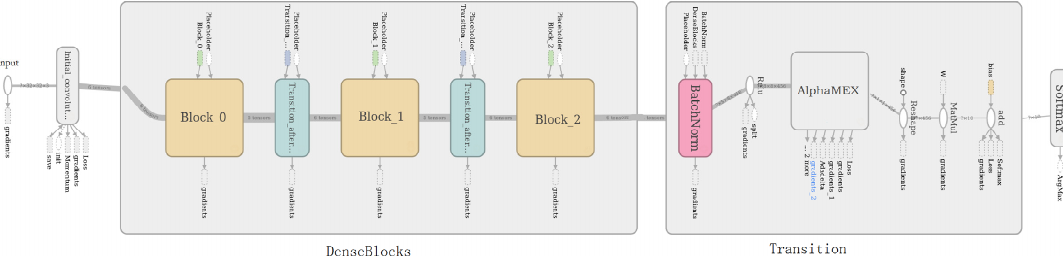
Figure 10. The AlphaMEX-DenseNet40 architectures for CIFAR. Compared to the original DenseNet40 in Figure 2, the global average pool layer has been replaced by the proposed AlphaMEX Global Pool without changing any other layers.